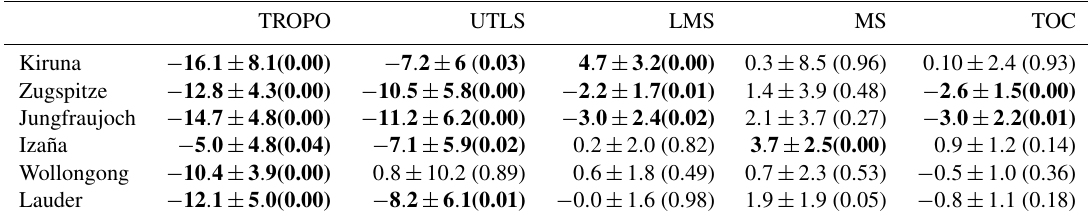
Table 3. IASI-A decadal drifts and their 2 σ standard deviation (in percent) calculated from the monthly relative differences between IASI and the FTIR data over the period from 2008 to 2017 for the TOC and different partial ozone columns: surface–300hPa (TROPO), 300–150hPa (UTLS), 150–25hPa (LMS) and 25–3hPa (MS). The P value is indicated in parentheses. A P value lower than 0.05 indicates a significant drift; drifts indicated in bold are significant. TROPO UTLS LMS MS TOC